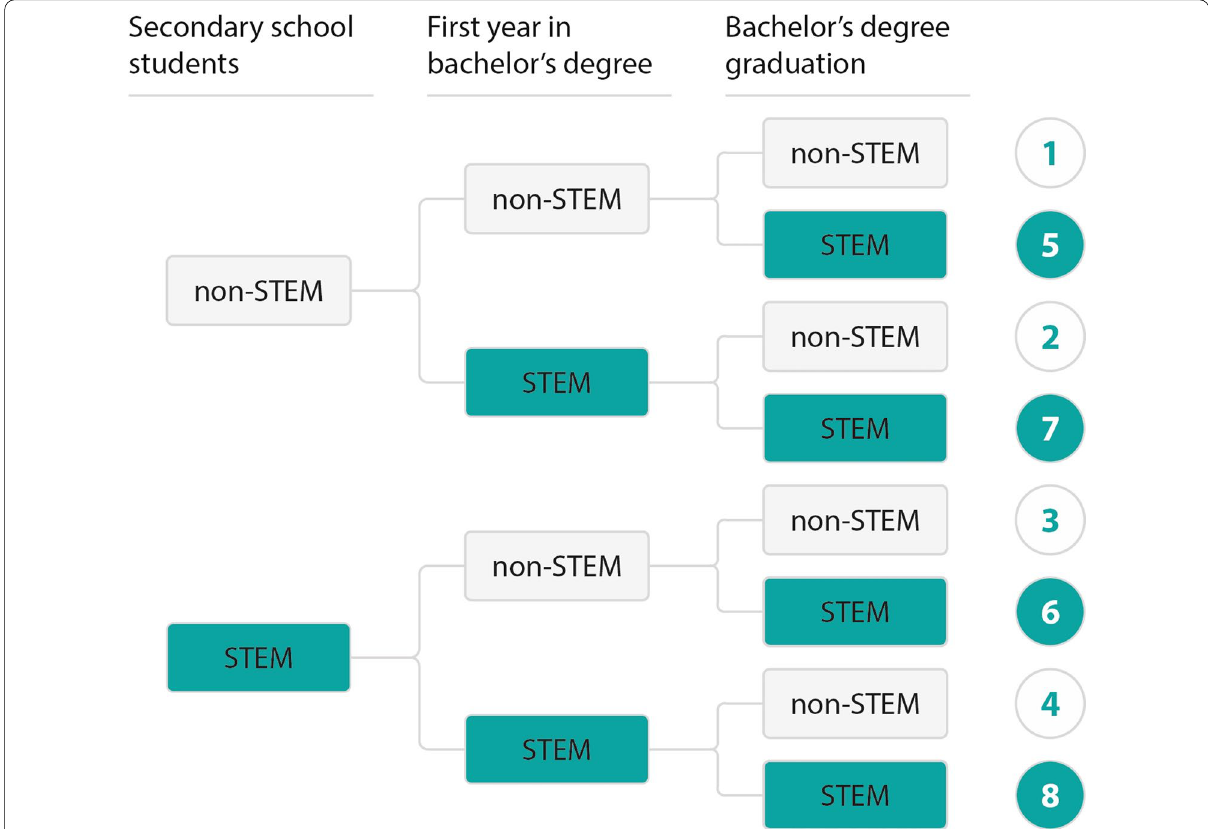
Fig. 3 The three‑tier tree, representing eight pathways toward a STEM or non‑STEM